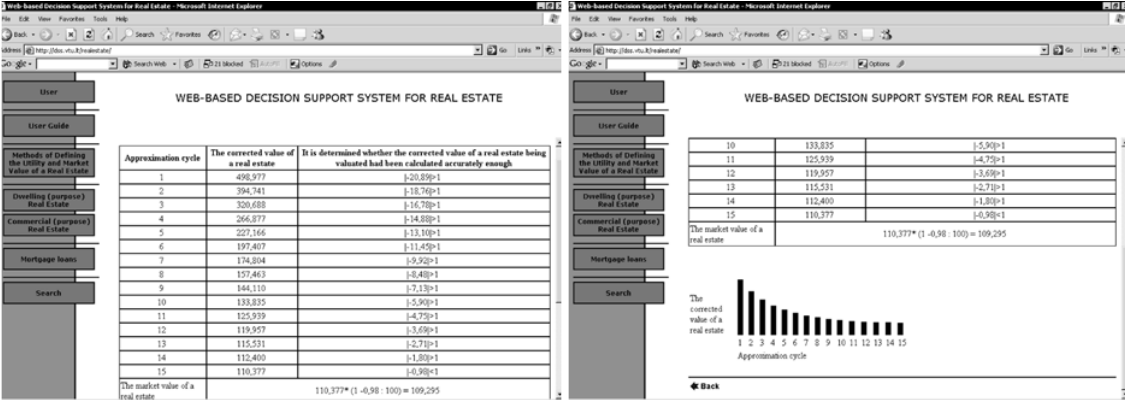
Figure 4. Calculation of the market value: presentation of the market value’s calculations in numerical form ( left ); presentation of the market value’s calculations in graphic form ( right )